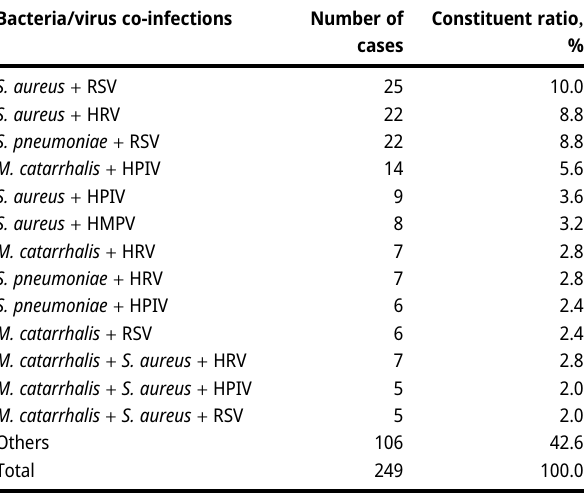
Table  : The bacteria-virus co-infections in respiratory infection cases. Bacteria/virus co-infections Number of